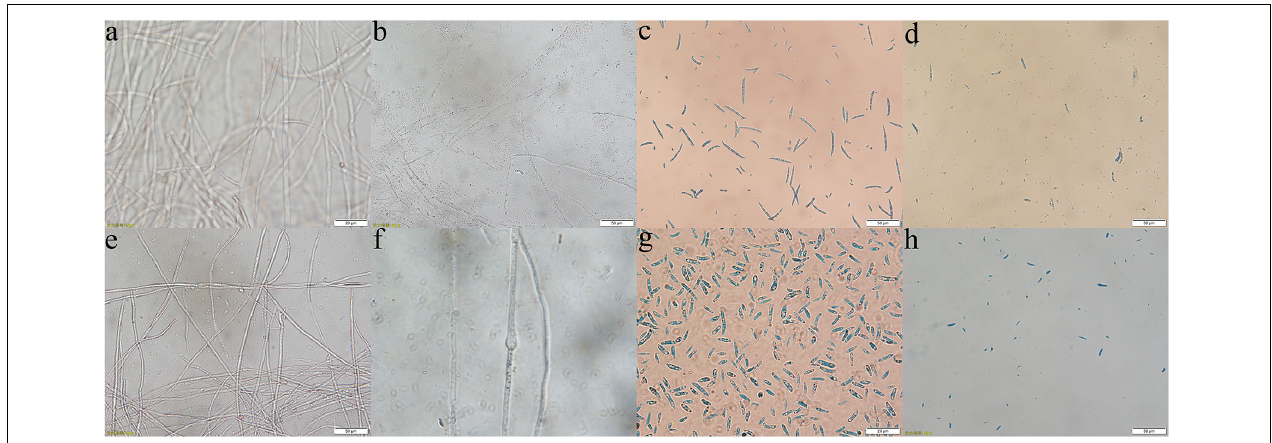
FIGURE 4 | Effect of C3 on pathogenic mycelium and spore morphology ( a–d : Y-5; e–h : Y-11; a,e,c,g : mycelium and spores of the control group; b,f,d,h : mycelium and spores treated with